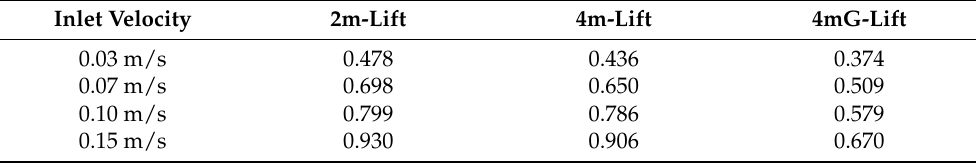
Table 1. Maximum velocity with different gas velocities produced by different lifts